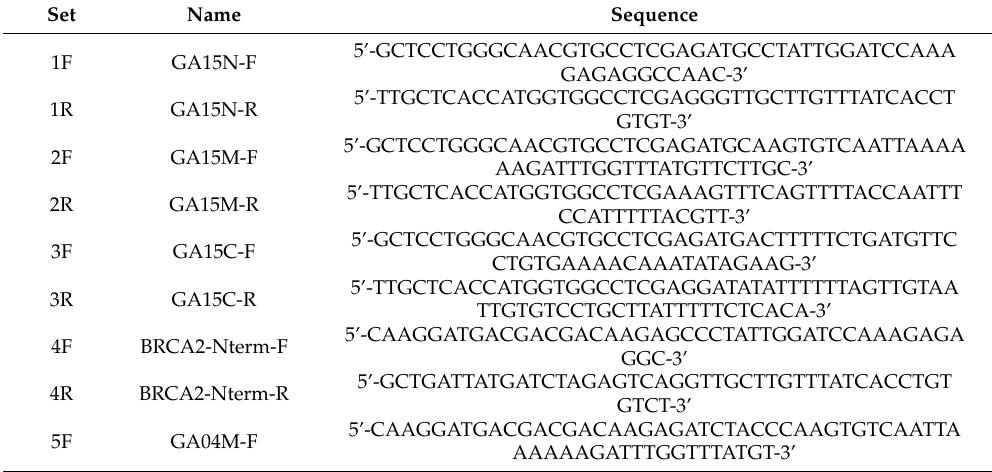
Table 3. List of oligonucleotides used in this